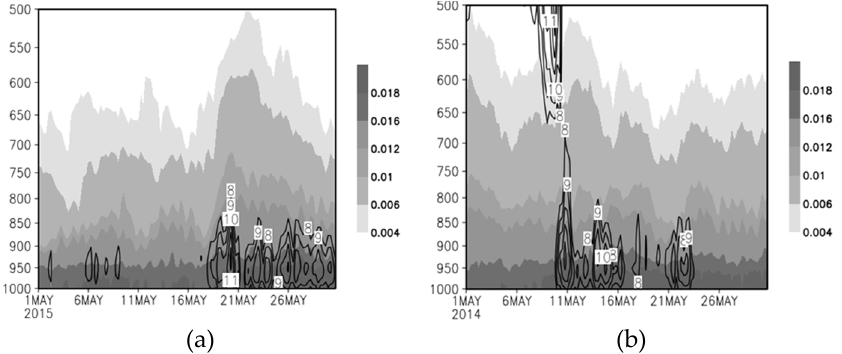
Figure 14. ERA interim daily fields of the time series of the wind speed (ms − 1 ) and specific humidity (shaded, gkg − 1 ) below 500 hPa in May of ( a ) 2015 and ( b ) 2014 from the averaged area over the SCS shown in Figure 13. Table 1. Parameters within the PBL according to the Hong Kong sounding during the WSTR in May from 2013 to 2016. MWS denotes the maximum wind speed, and LEV represents the corresponding level, whereas PW denotes the precipitation water for the entire sounding.